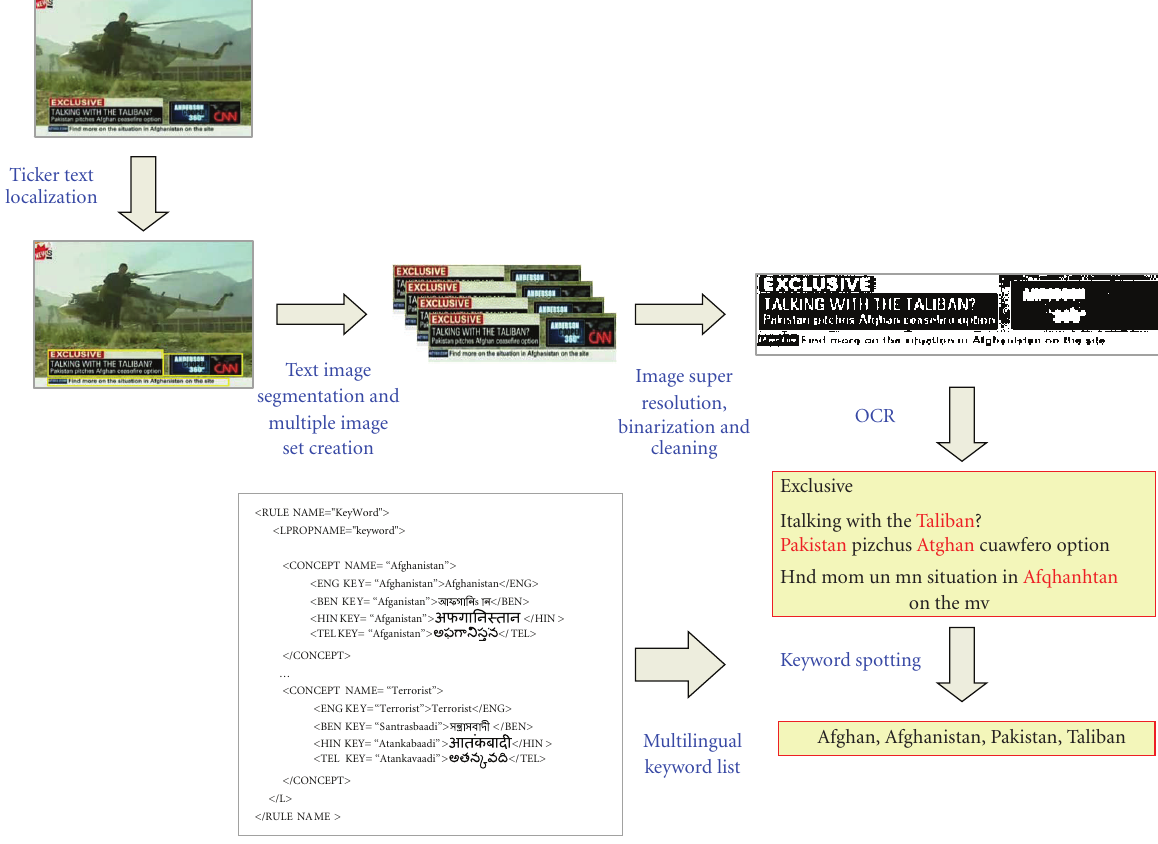
Figure 4: Keyword extraction from ticker